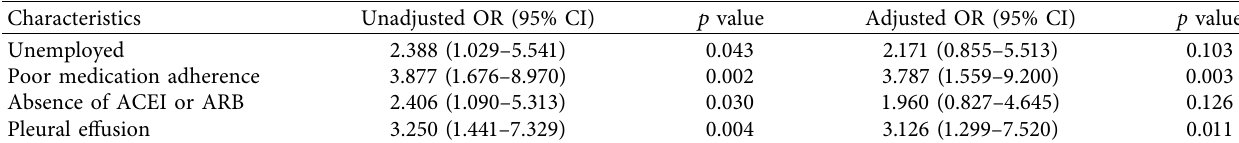
Table 3: Multivariate analysis of risk factors for heart failure readmission ( N �